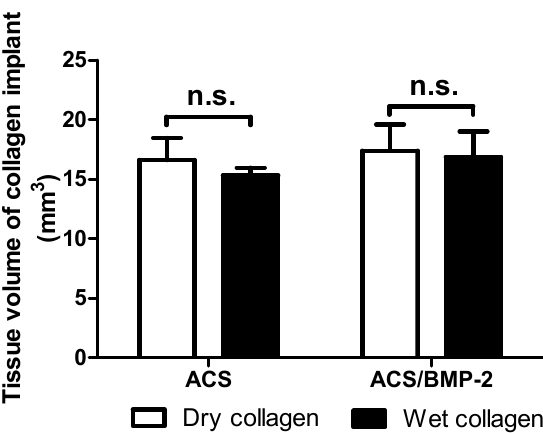
Figure 2. Mean volumes of collagen implants. No significant differences were found between dry ACS and dry ACS/BMP-2 nor between wet ACS and wet ACS/BMP-2. Data were present as Means ± SEM. n.s.: no significant difference.